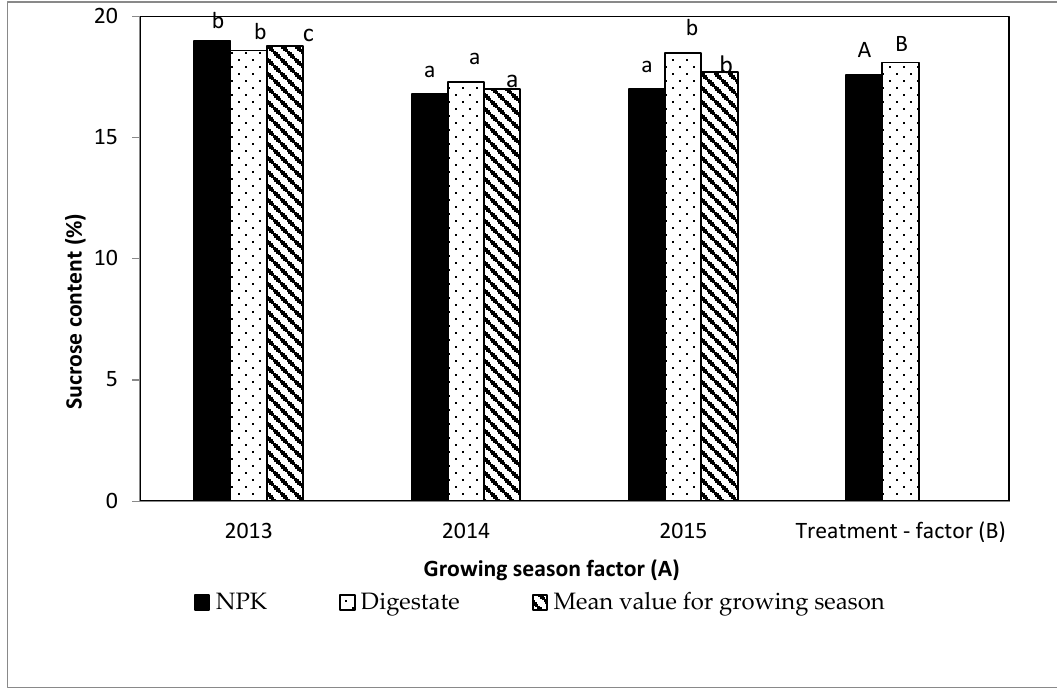
Figure 5. Effects of growing seasons and fertilization treatments on concentration of sucrose in sugar beet roots.